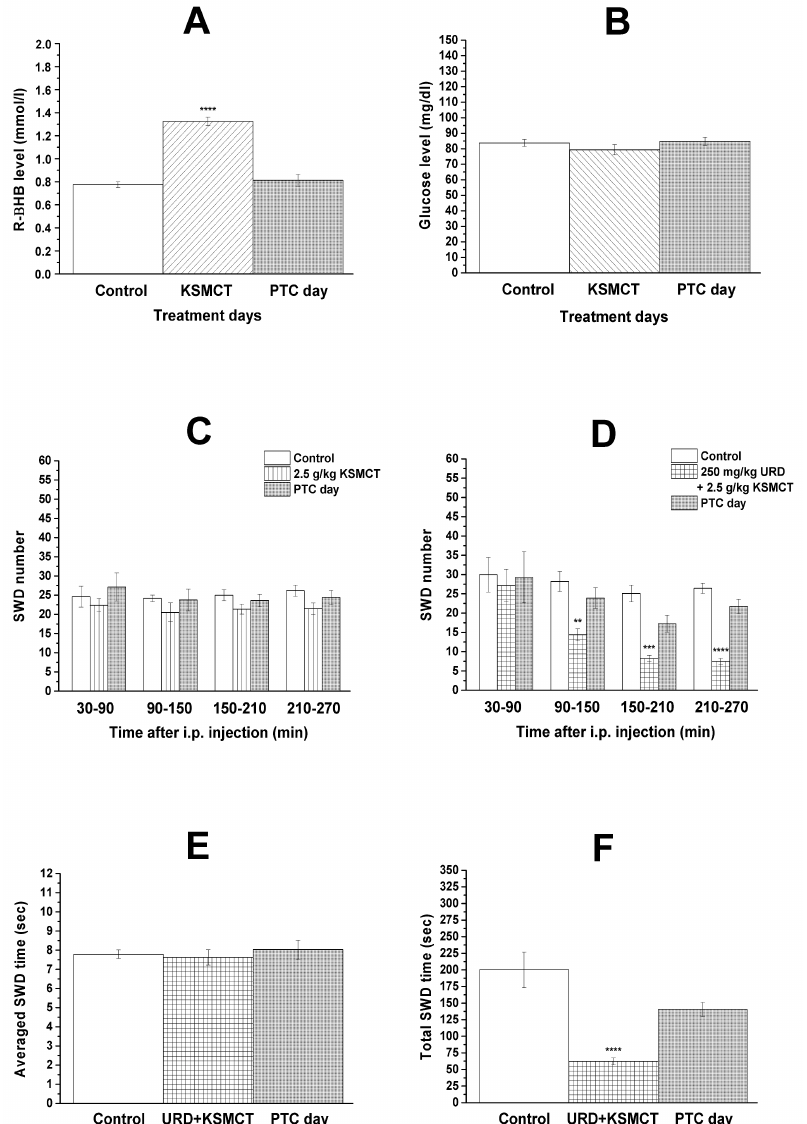
Figure 3. Effect of KSMCT (2.5 g/kg, gavage) alone on blood R- β HB ( A ) and glucose levels ( B ) as well as SWD number ( C ). Influence of combined administration of uridine (i.p. 250 mg/kg) with KSMCT (2.5 g/kg, gavage) on SWD number ( D ) between 30 and 270 min and averaged SWD time ( E ) and total SWD time ( F ) between 150 and 210 min. Abbreviations: i.p., intraperitoneal; KSMCT, mix of ketone salt (KS) and medium chain triglyceride (MCT) oil in a 1:1 ratio; PTC day, post-treatment control day; R- β HB, R-beta-hydroxybutyrate; SWD, spike-wave discharge; URD, uridine. **: p < 0.01, ***: p < 0.001, ****: p <